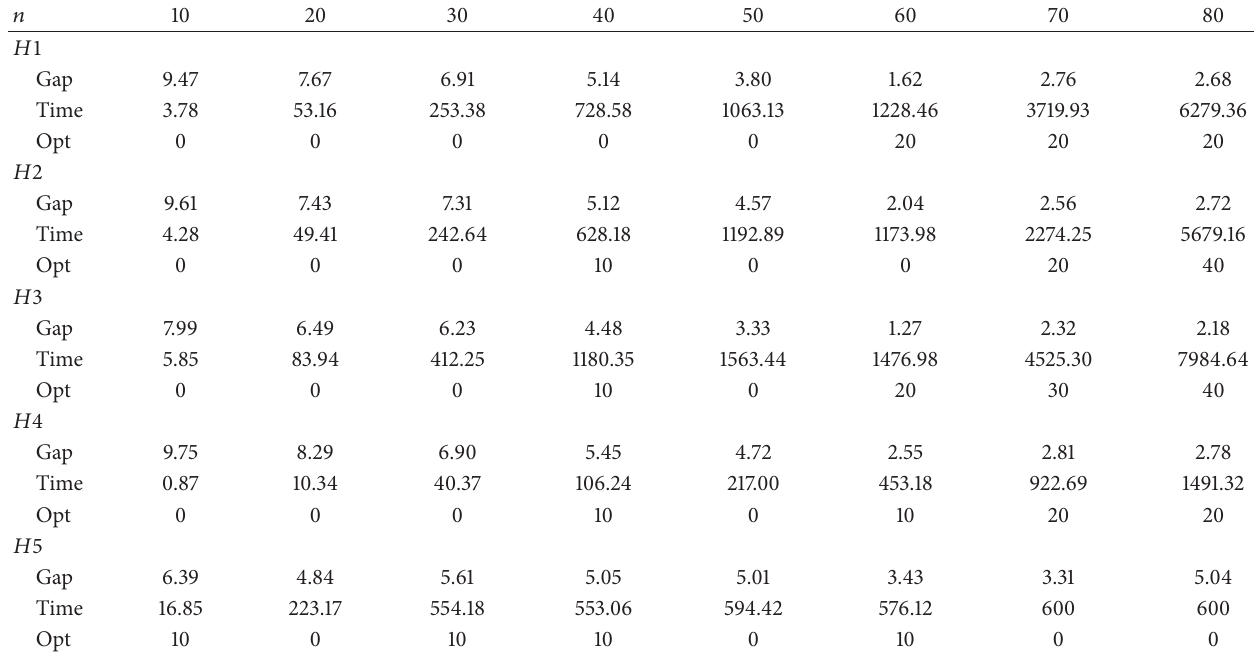
Table 15: Performance of the heuristics for 𝑚 =